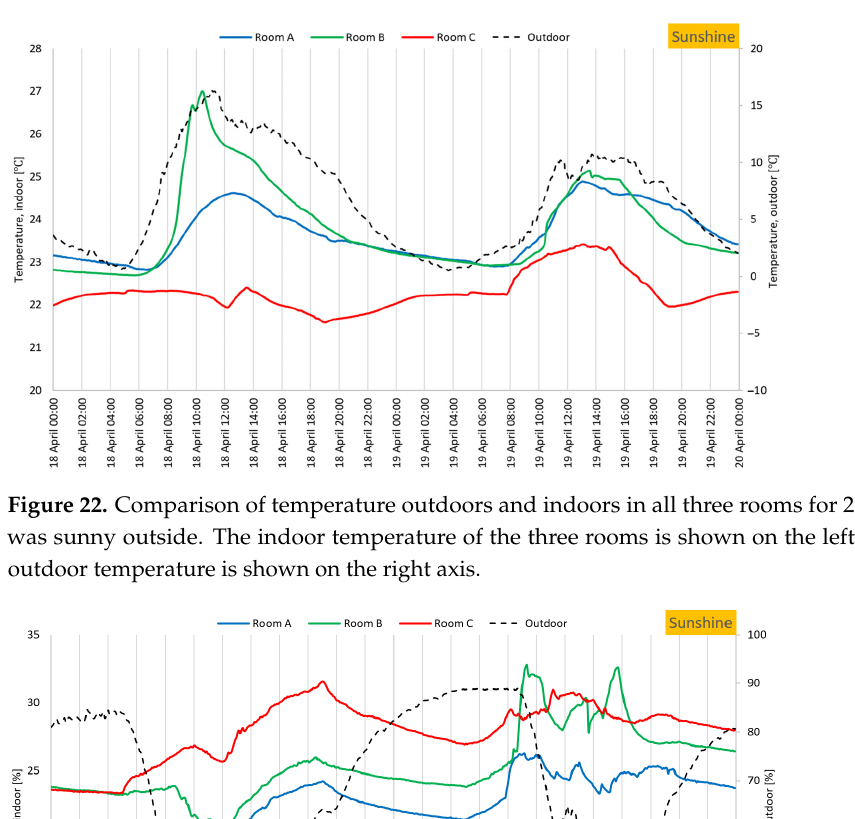
Figure 21. Comparison of RH outdoors and indoors in all three rooms for 1 day when it was cloudy outside. The indoor RH of the three rooms is shown on the left axis, and the outdoor RH is shown on the right axis.